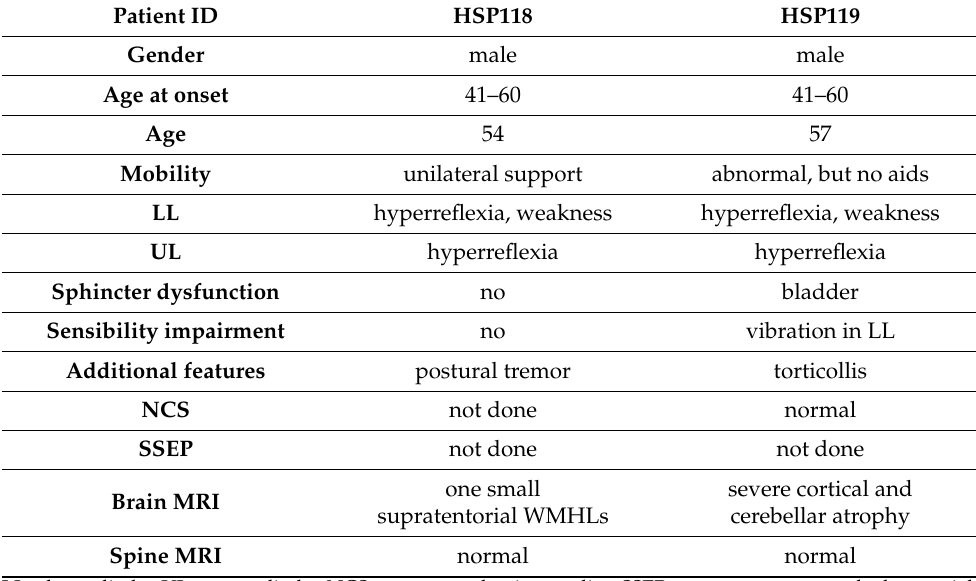
Table 5. Clinical findings of Serbian patients with genetically confirmed SPG7.